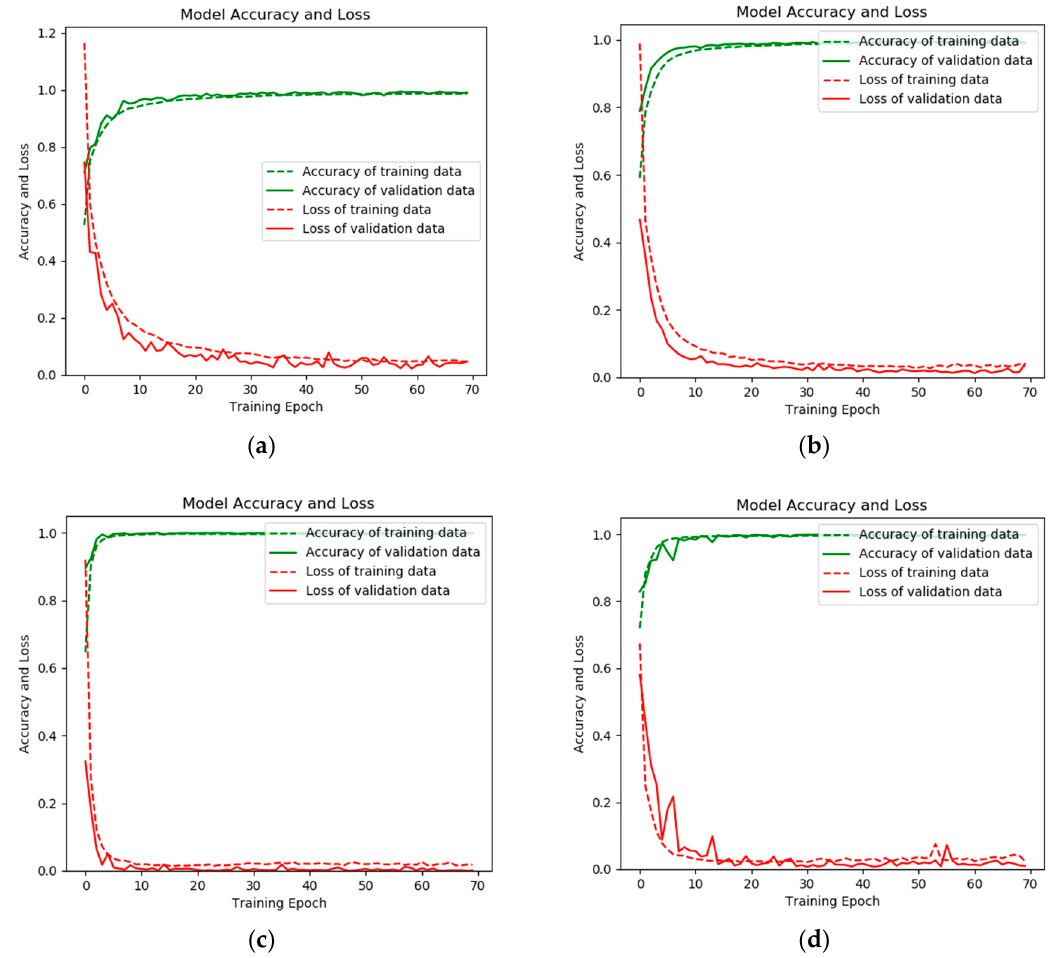
Figure 12. The loss value and accuracy of both the training and validation processed on RP-1043 with fault severity ( a ) level I , ( b ) level II , ( c ) level III , and ( d ) level IV .